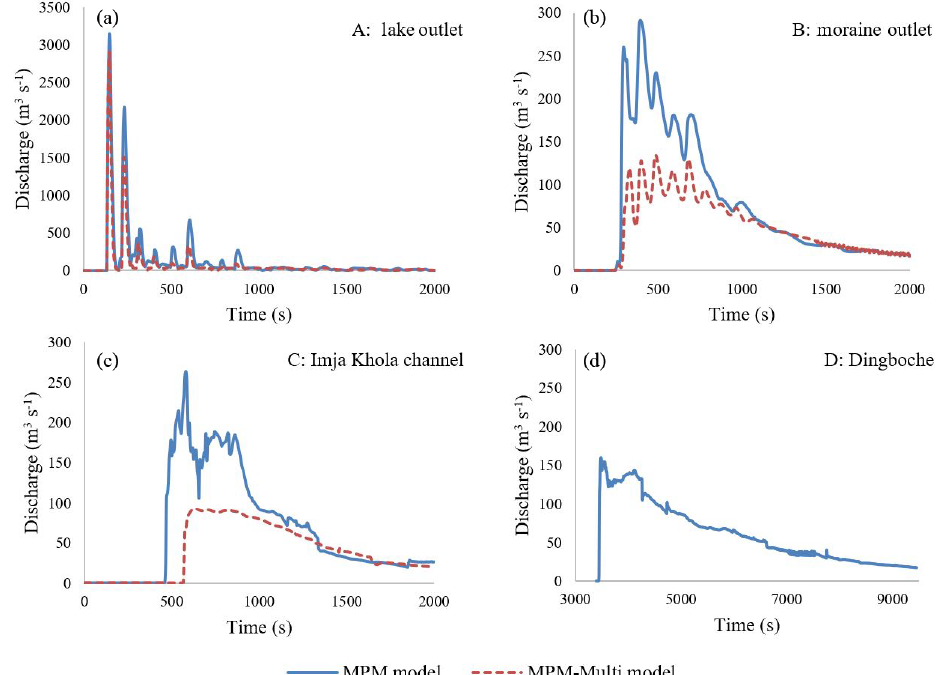
Figure 8. Combined sediment and water discharge for the first 2000s after initial wave generation from a large southeast avalanche at all three cross sections for both the MPM model (blue line) and the MPM-Multi model (red line), plus debris discharge for the first 9500s at Dingboche for the MPM model. Note the larger discharge scale of (A).